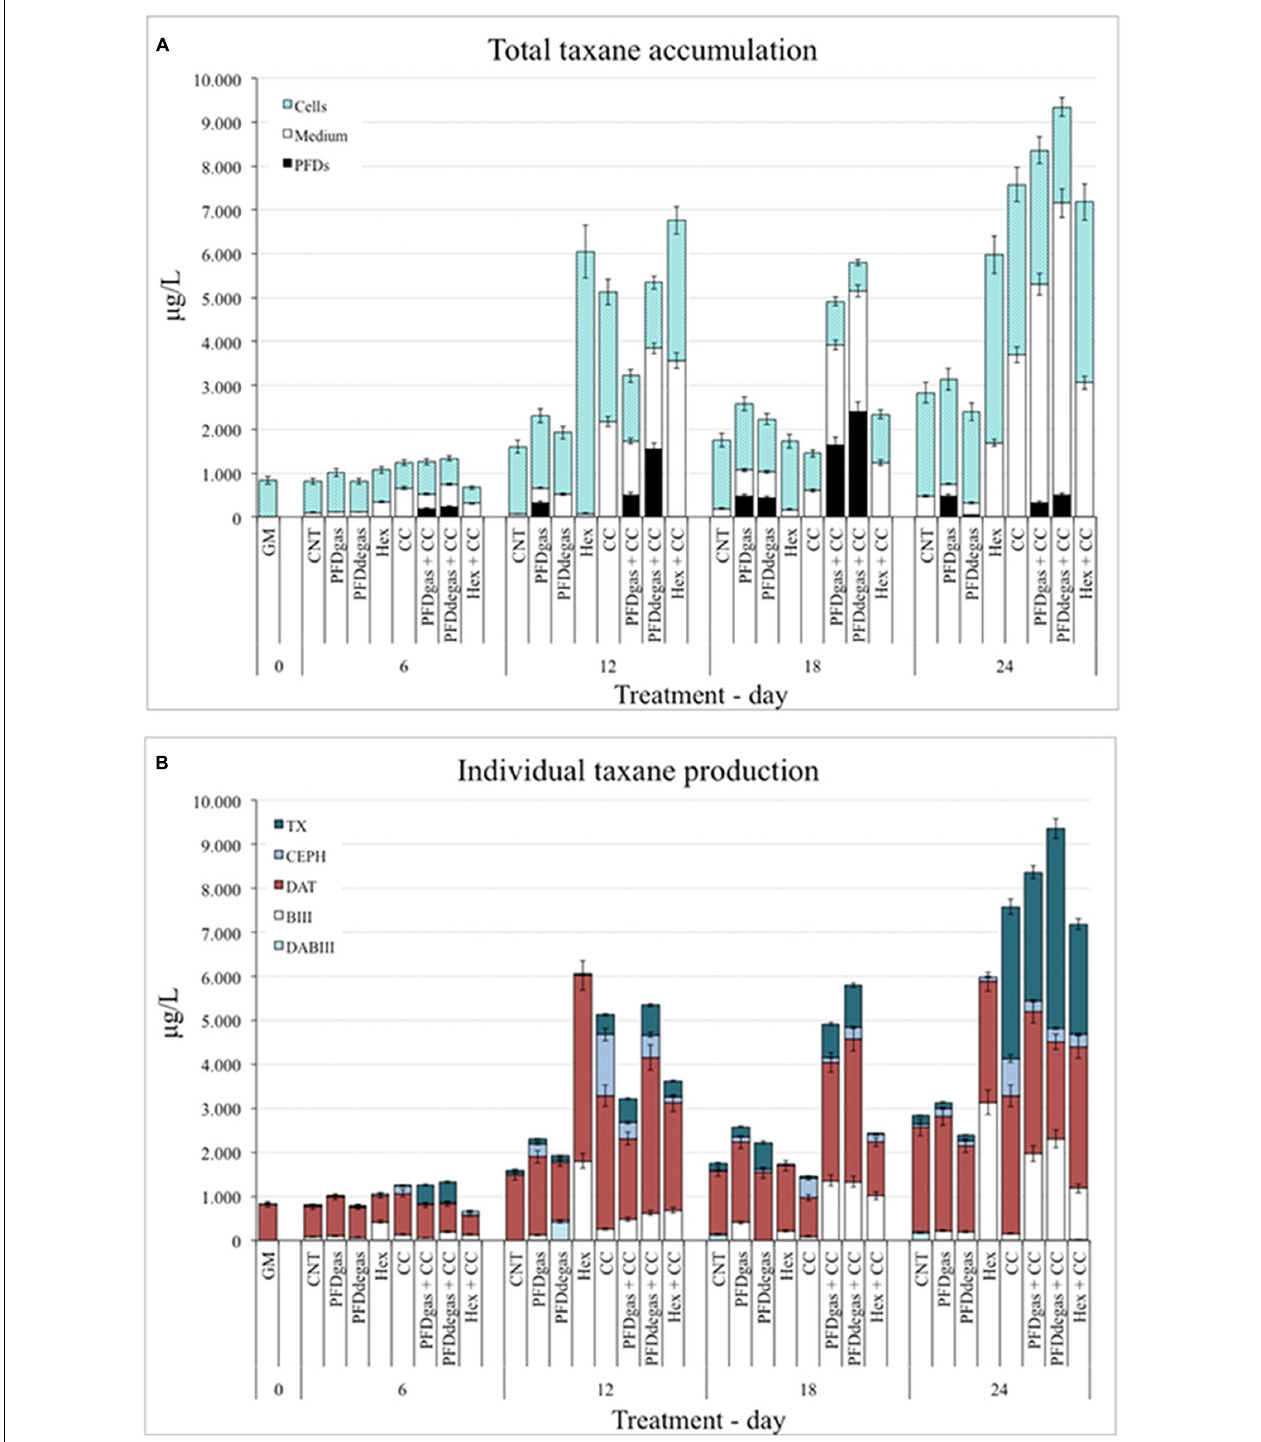
FIGURE 3 | (A) Total taxanes accumulated inside the cells, culture medium and PFD phase at 24 days of the T. media cell cultures. GM, biomass production medium; CNT, control; PDFgas, gassed perfluorodecalins; PFDdegas, degassed perfluorodecalins; PDFgas + CC, gassed perfluorodecalins plus Coro and β -CDs; PDFdegas + CC, degassed perfluorodecalins and Coro + β -CDs; Hex, Hexenol; Hex + CC, Hexenol and Coro + β -CDs. Data are the mean of three independent replicates ± SD. (B) Individual taxane production in T. media cell cultures at 24 days of culture. GM: biomass production medium; CNT, control; PDFgas, gassed perfluorodecalins; PFDdegas, degassed perfluorodecalins; PDFgas + CC, gassed perfluorodecalins plus Coro and β -CDs; PDFdegas + CC, degassed perfluorodecalins and Coro + β -CDs; Hex, Hexenol; Hex + CC, Hexenol and Coro + β -CDs. Data are the mean of three independent replicates ± SD.